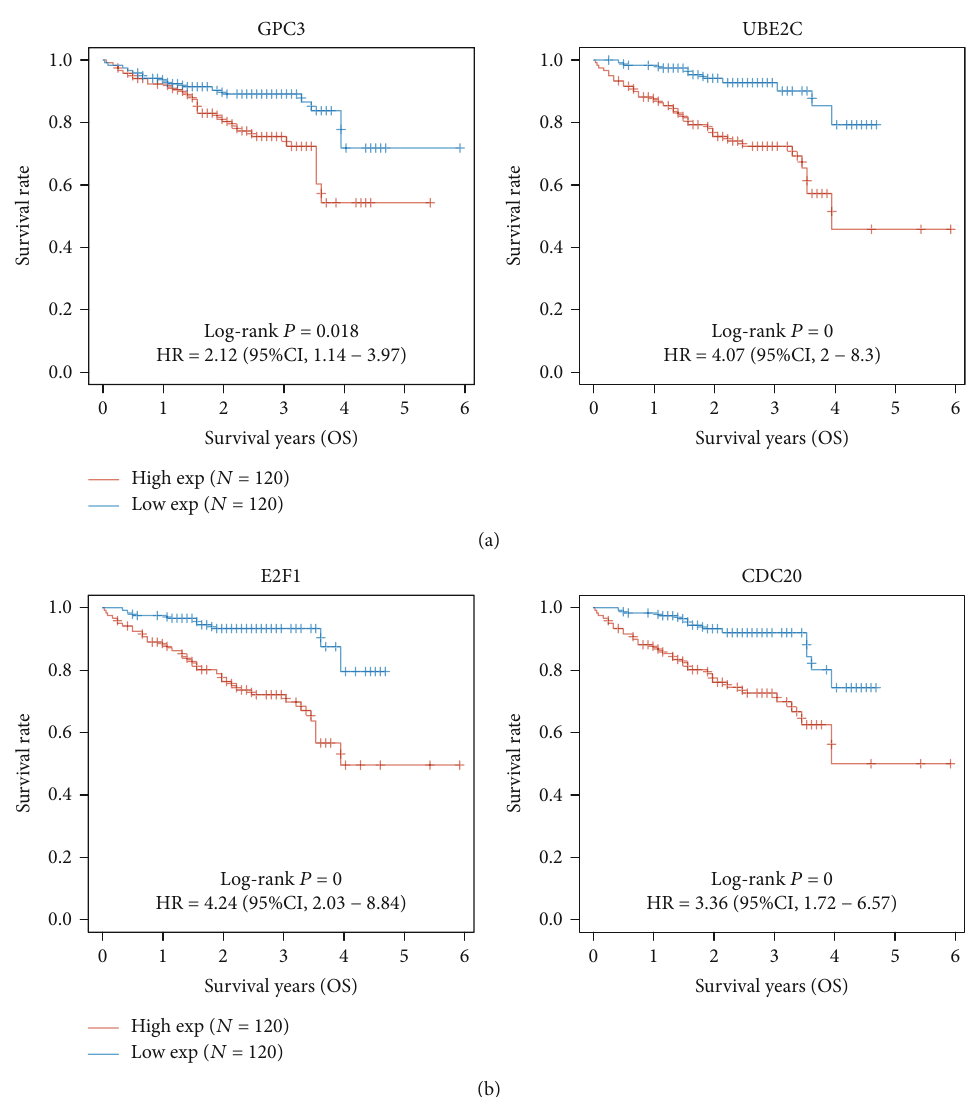
Figure 7: The prognosis value of the top 10 overexpressed genes in HCC from ICGC datasets. (a, b) CPC3, UBE2C, E2F1, and CDC20 were identi fi ed as OS-related